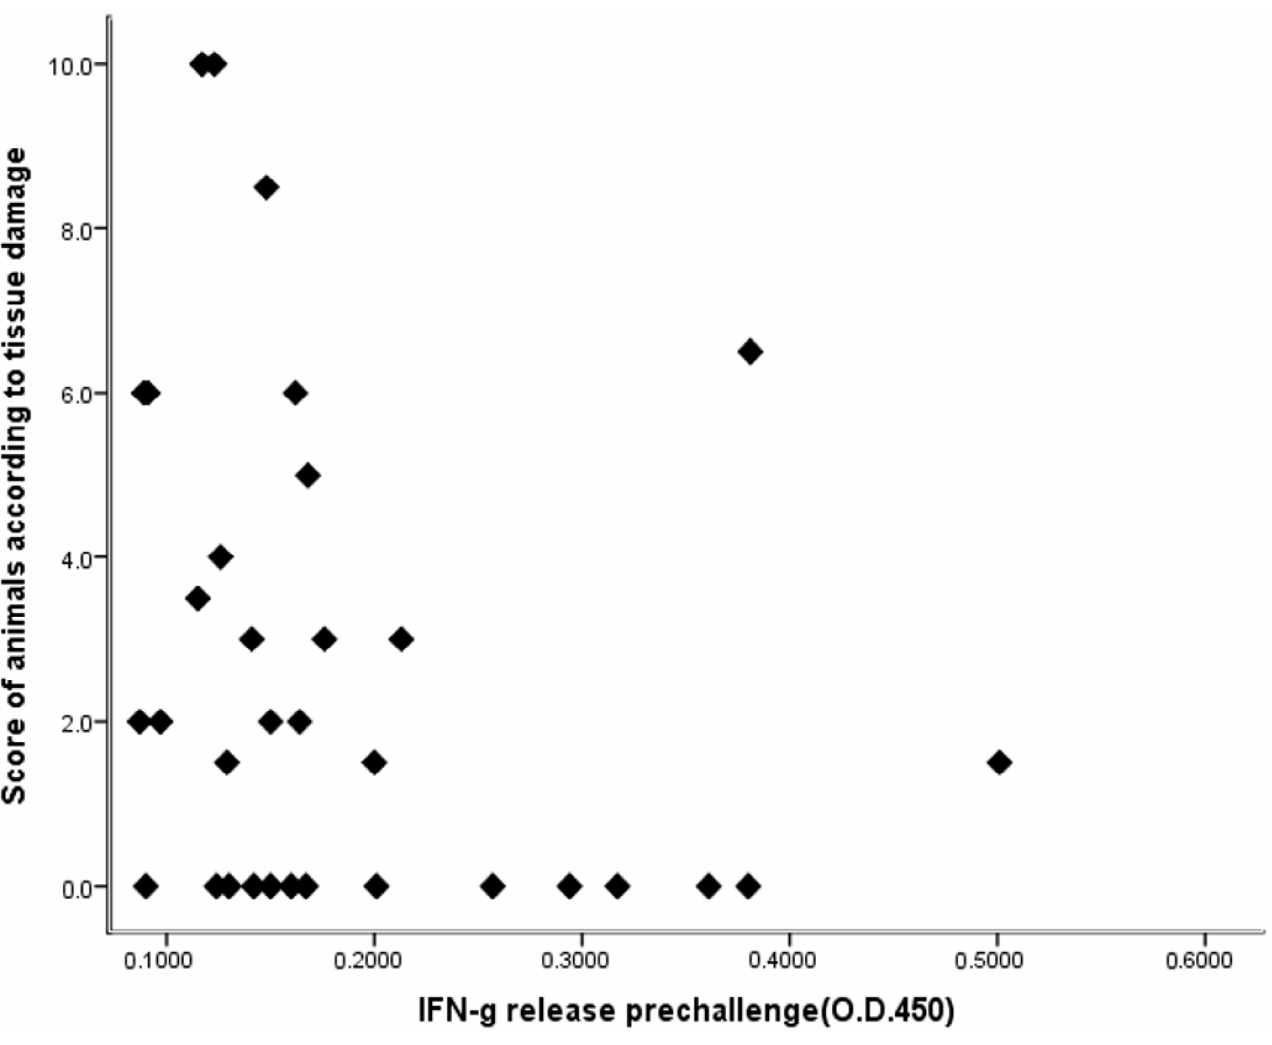
Figure 4. Relationship between the blood IFN- γ release 1 week prior to challenge and the lesion scores of the experimental animals vaccinated against TB with a BCG strain and challenged with a Mycobacterium bovis wild-type